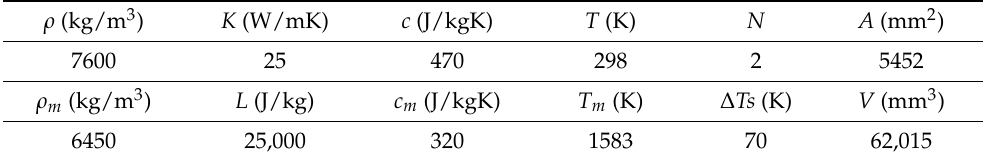
Table 4. The parameters used to calculate the solidification time by means of Chvorinov’s rule. The parameters were extracted from technical data sheets and scientific literature references